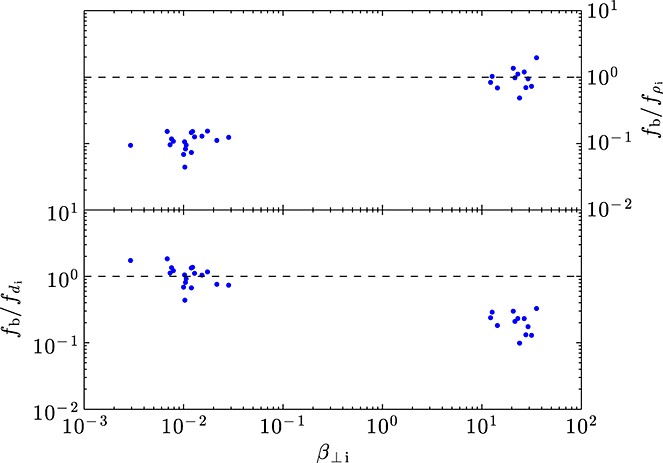
Ratio of measured break frequency fb to the frequency corresponding to (top) kρi=1 and (bottom) kdi=1, as a function of β⊥i for all intervals in which a break was measurable.